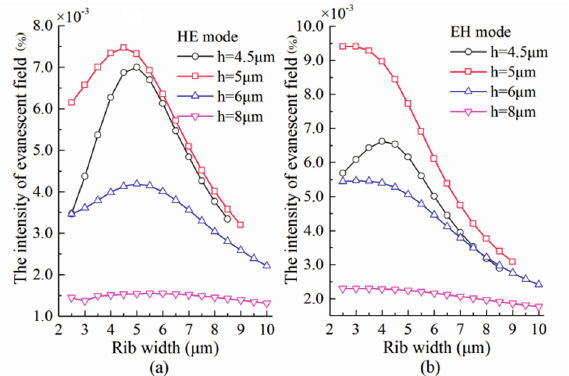
Figure 3. Dependence of the intensity of the evanescent field for homogeneous sensing on rib width ( w ) with different outside rib height (h). ( a ) HE polarization; ( b ) EH